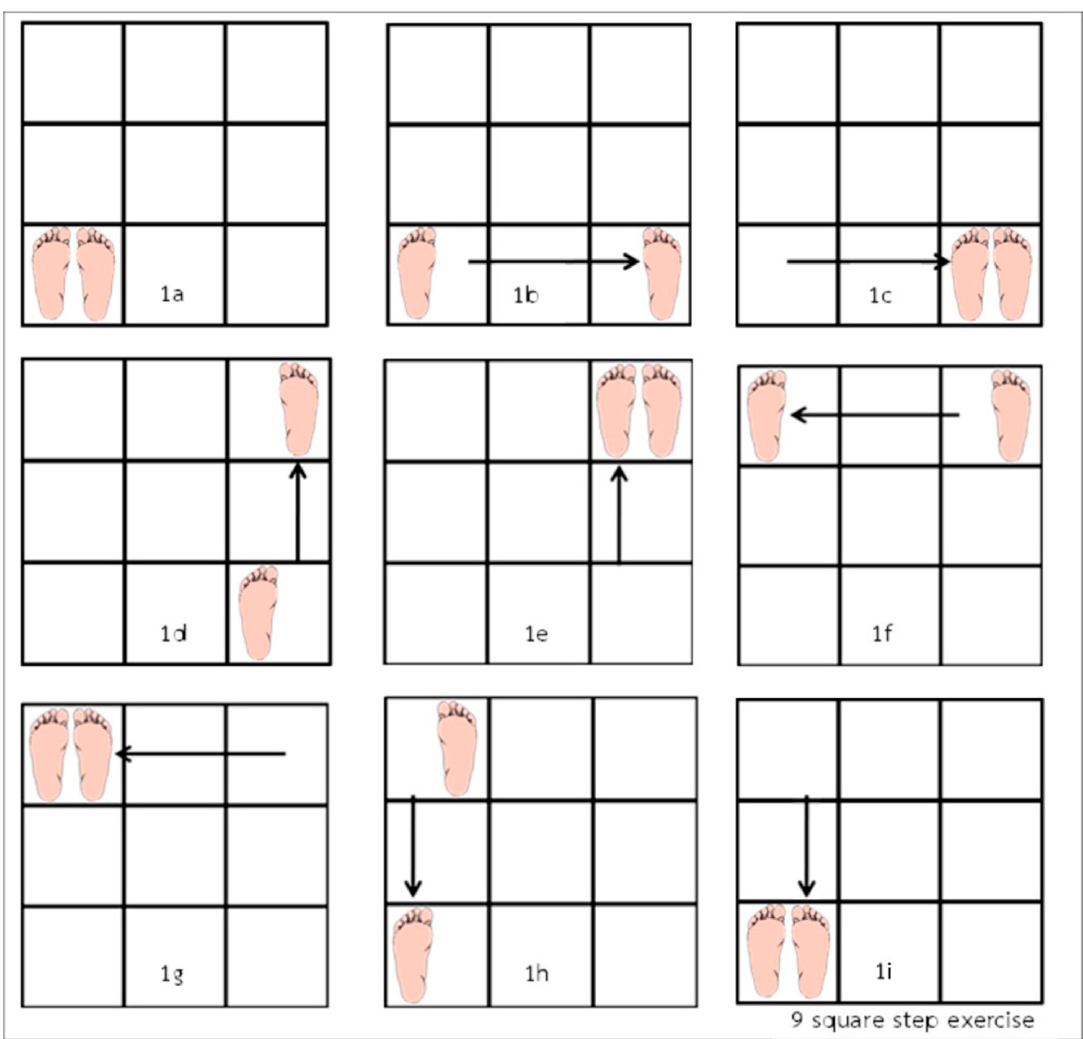
Figure 1. Nine-Square Step protocol [22].